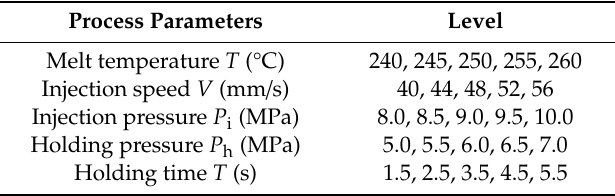
Table 3. Micro injection molding process parameters.